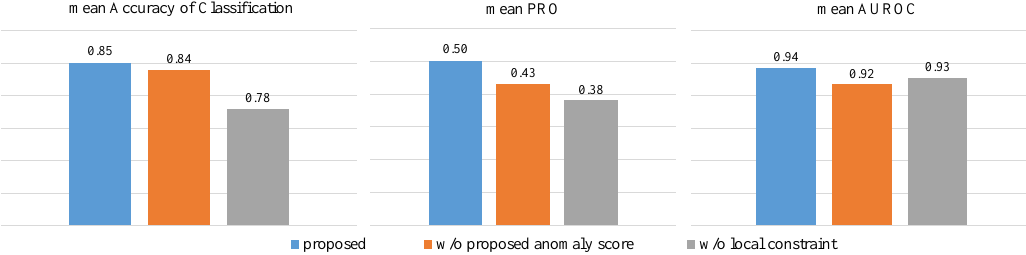
Figure 8. Results of ablation experiment. Blue is the proposed method, orange is the condition with input–output residuals as anomaly scores, and grey is the condition without local